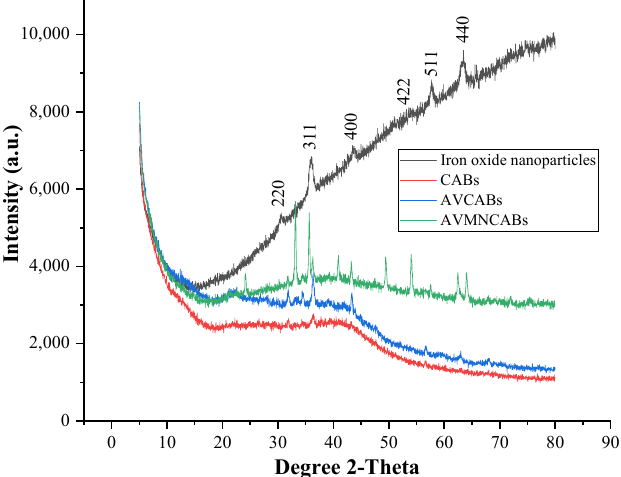
Figure 3. XRD patterns of iron oxide (Fe 3 O 4 ) nanoparticles, CABs, AVCABs, and AVMNCABs, with the characteristic peaks of Fe 3 O 4 identified. Table 1. Average crystal size of CABs, AVCABs, and AVMNCABs calculated using Debye–Scher- rer’s formula.